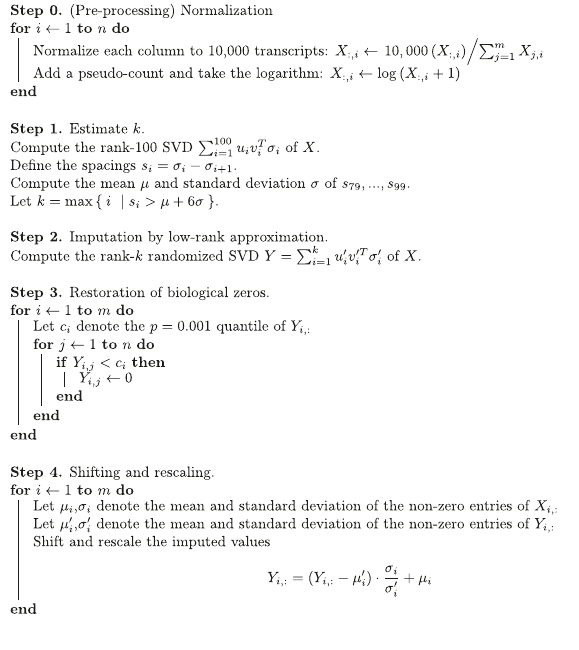
Algorithm 1 . Adaptively thresholded Low-Rank Approximation